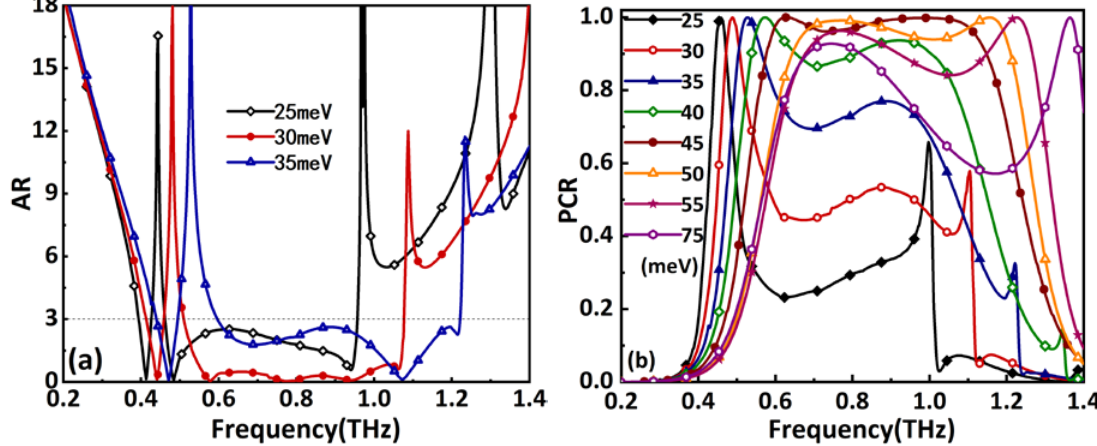
Figure 6. ( a ) AR and ( b ) PCR related to E F .